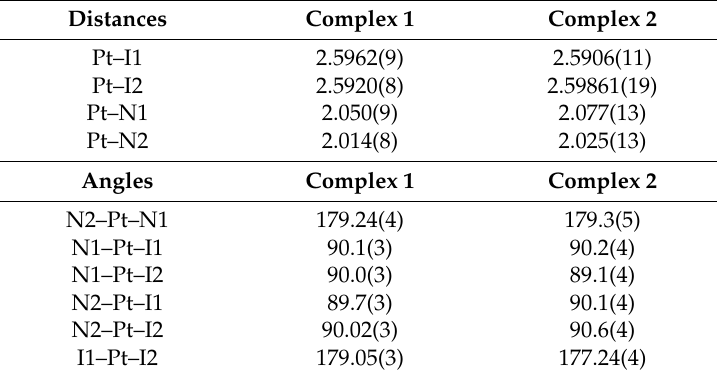
Figure 2. Molecular views: ( a ) complex 1 ( b ) complex 2 . Table 1. Selected distances (Å) and angles (°) in complexes 1 and 2 .